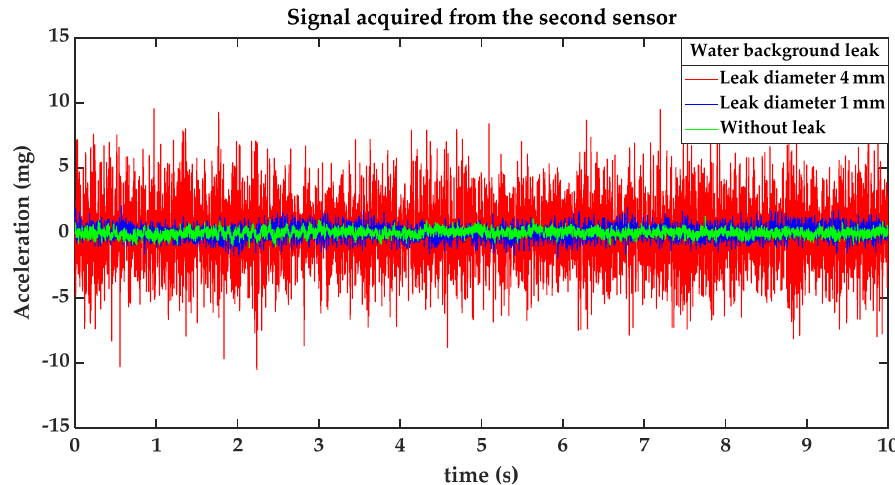
Figure 8 . Signals were acquired from the first sensor with a background leak of 1 mm and 4 mm in diameter.